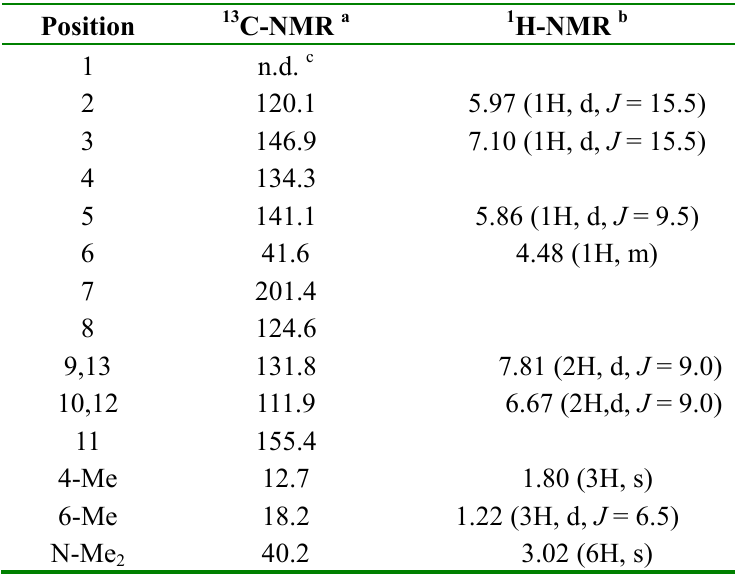
Table 1. 1 H-NMR and 13 C-NMR data of the compound, 9179B.